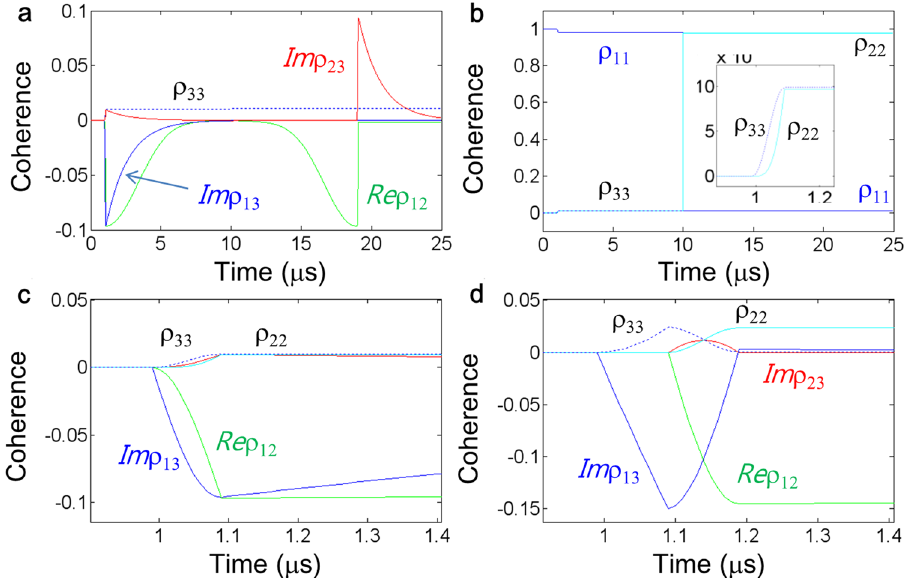
Figure 2. Controlled echo calculations for resonant Raman data. ( a )-( c ) Numerical results of Fig. 1(c) when A and B in Fig. 1 form a resonant Raman pulse. All others are same as Fig. 1. Dotted: ρ 33 ; cyan: ρ 22 ; Red: Im ρ 23 ; Blue: Im ρ 13 ; Green: Re ρ 12 . ( d ) Details of Fig. 1(c) to compare with ( c ). The pulse area of the data D is π , where the 2 2 Ω = Ω + Ω = . Ω = 0.5 MHz. All other parameters are the generalized Rabi frequency of D is MHz 5 A D A B same as in Fig.